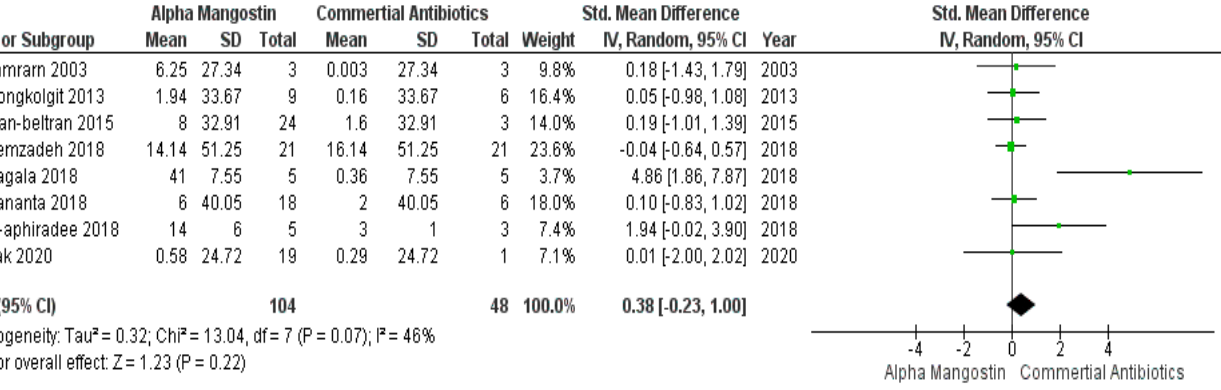
Figure 3. Forest plot of studies on commercially available antibiotics and alpha mangostin.